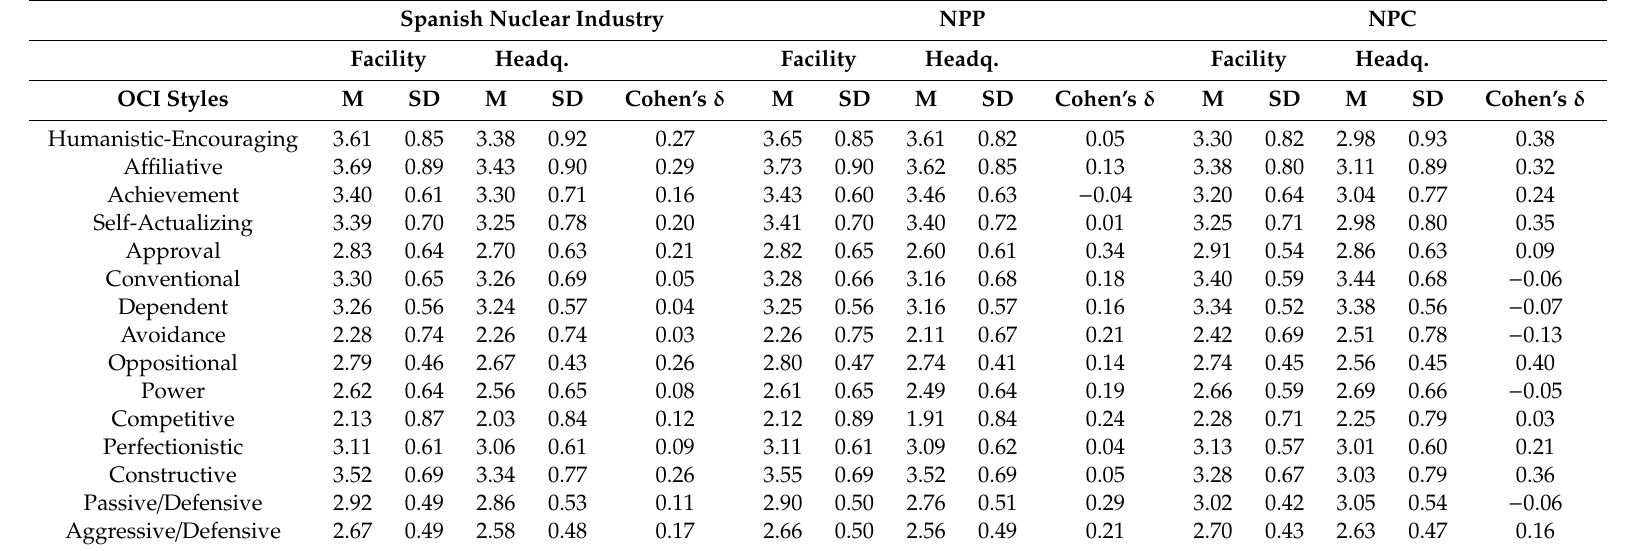
Table 7. Descriptive statistics of the OCI organizational cultures and styles by work